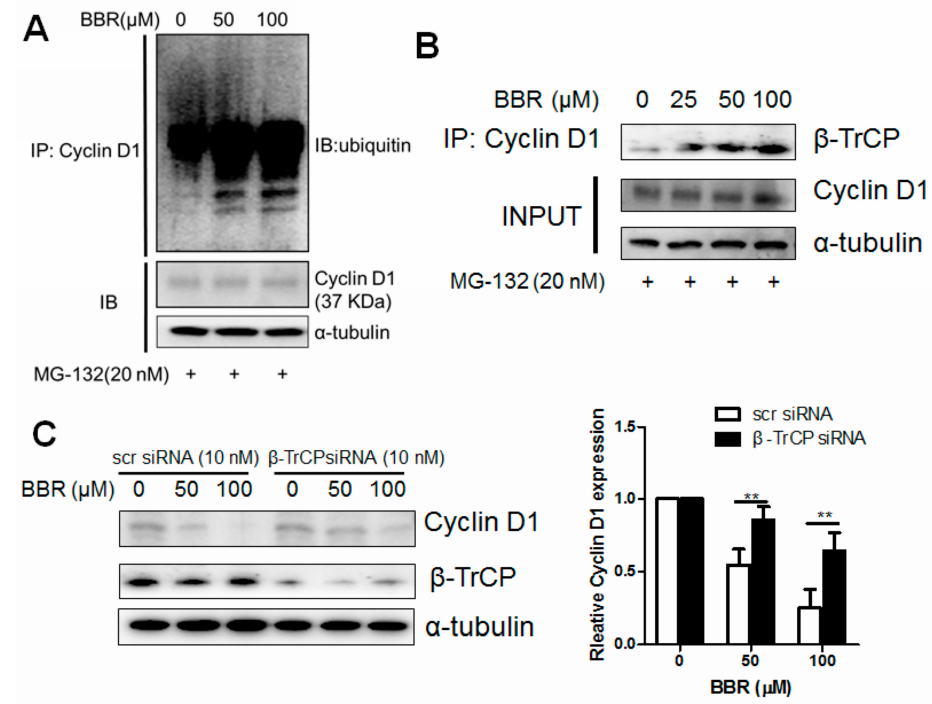
Figure 3. Berberine induces Cyclin D1 ubiquitination and recruits β -TrCPas an E3 ligase. ( A ) Cells were treated by berberine for 6 h in the presence of MG-132 (20 nM). Ubiquitinated Cyclin D1 was precipitated with antibody against Cyclin D1 and detected with ubiquitin antibody; ( B ) Cells were treated with berberine for 6 h in the presence of MG-132 (20 nM). Ubiquitinated Cyclin D1 was precipitated with antibody against Cyclin D1 and β -TrCP was detected with β -TrCP antibody; ( C ) shows that genetic knockdown of β -TrCP attenuates berberine ′ s effect on Cyclin D1 degradation. (+ means presence of the chemicals), ** p < 0.01.